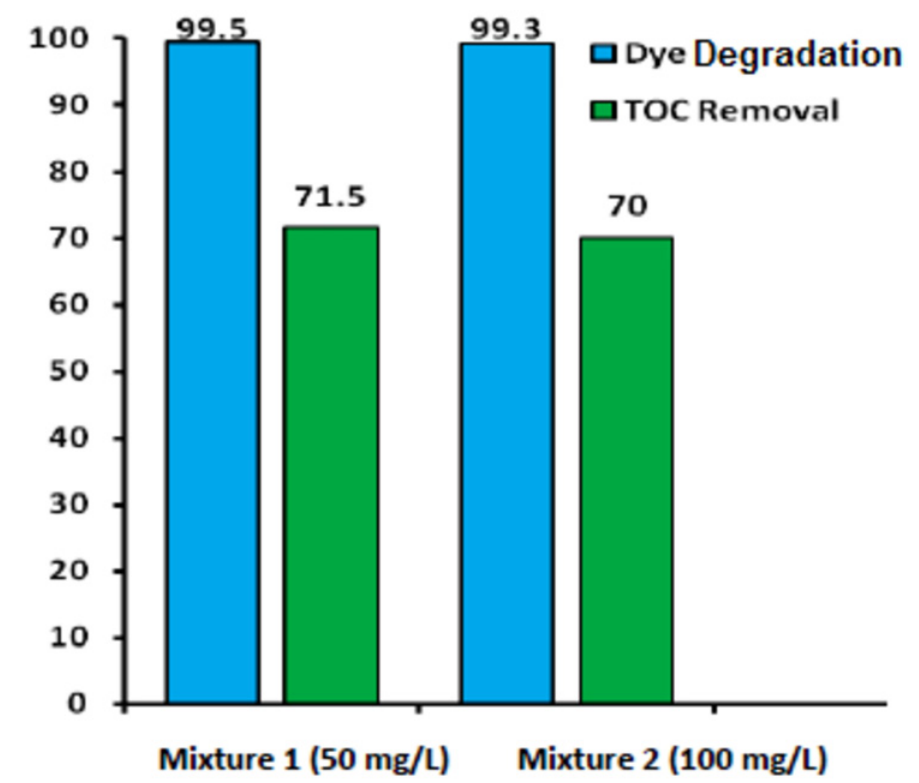
Fig 10. Degradation and TOC removal of mixture of dyes using